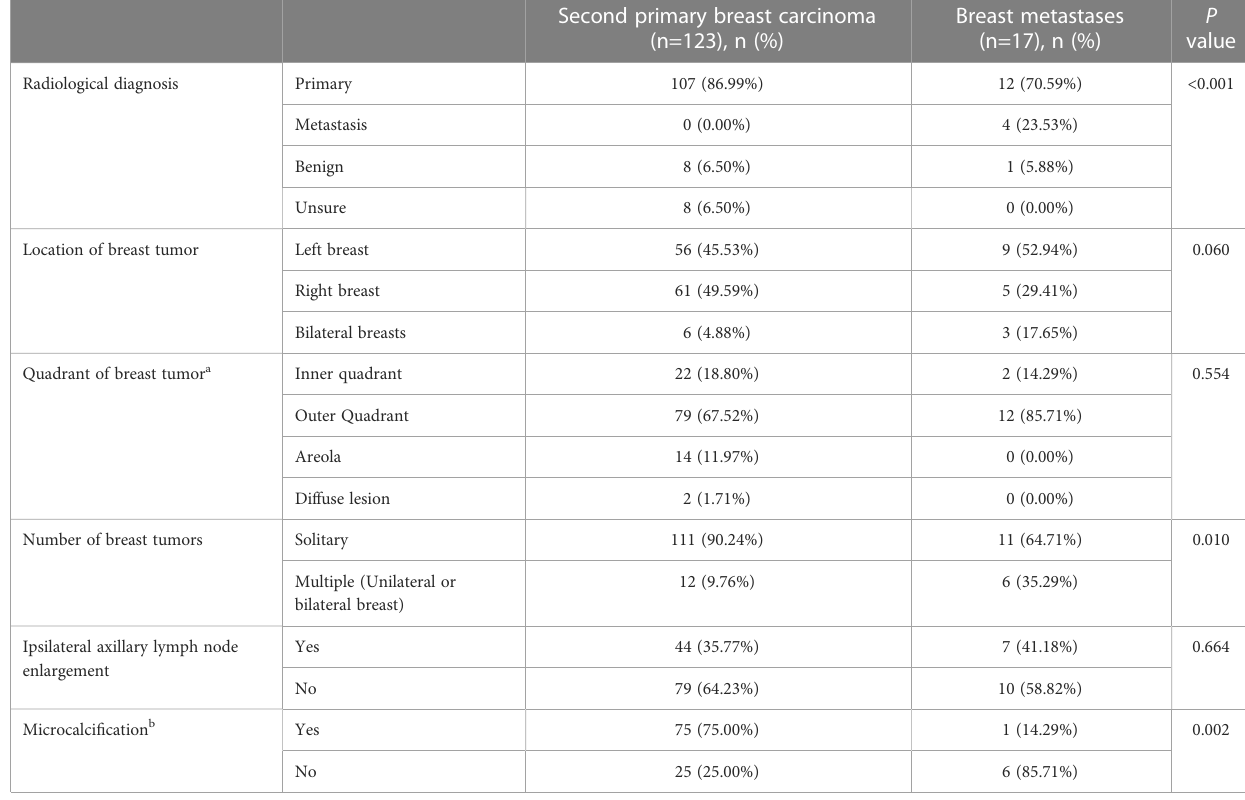
TABLE 5 Radiological characteristics of patients with second primary breast carcinoma and with those of breast